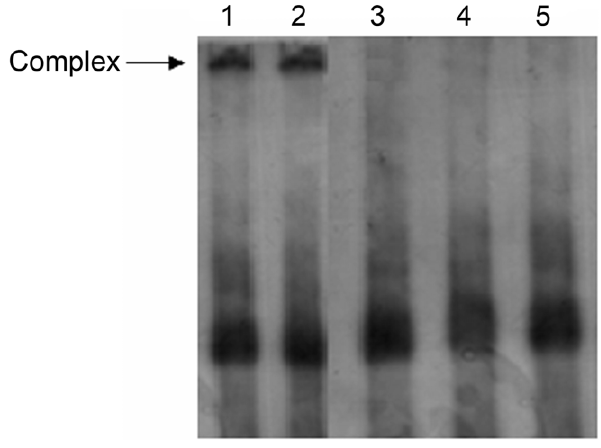
Figure 3. Specific interaction between zebrafish TS and its cognate mRNA in vitro. A gel shift experiment was performed using 32 P-labeled full-length TS mRNA as the probe. Zebrafish TS protein (100 ng) was incubated with 32 P-labeled full-length TS mRNA (lane 1, arrow). One hundred-fold molar excess luciferase mRNA did not affect the interaction between TS protein and mRNA (lane 2). In lane 3, 100- fold molar excess of unlabeled TS mRNA was included in the incubation buffer. Using bovine serum albumin in place of the TS protein did not result in any specific interaction (lane 4). Lane 5 contained 100 ng 32 P- labeled zebrafish TS mRNA only.